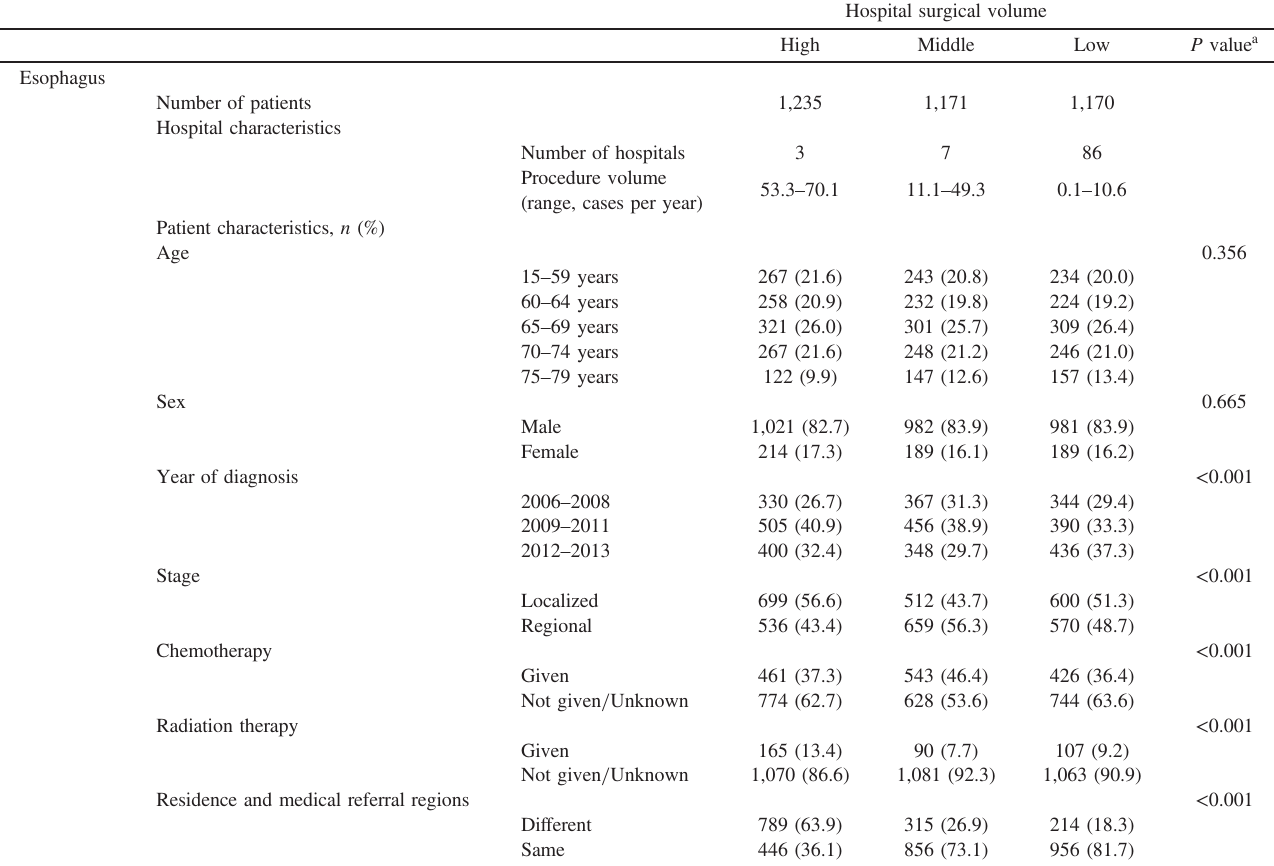
Table 1. Characteristics of esophageal cancer patients undergoing curative surgery at high-, middle-, and low-volume hospitals, based on data from the 2006 – 2013 Osaka Cancer Registry Database ( n =